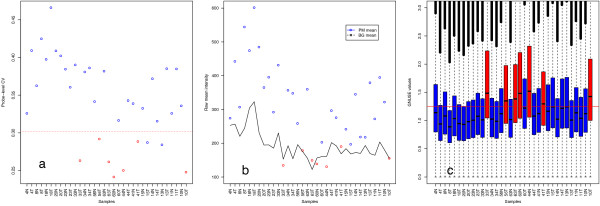
Array quality metrics. a) Raw coefficient of variation across all probes by sample, the red line represents our chosen threshold which is calculated as 2SD from the mean of CVs for arrays with RINs > 6. b) Raw perfect match mean - background mean c) Global normalised unscaled errors (GNUSE) across probes for each array. Samples that were flagged during quality assessment are highlighted in red.